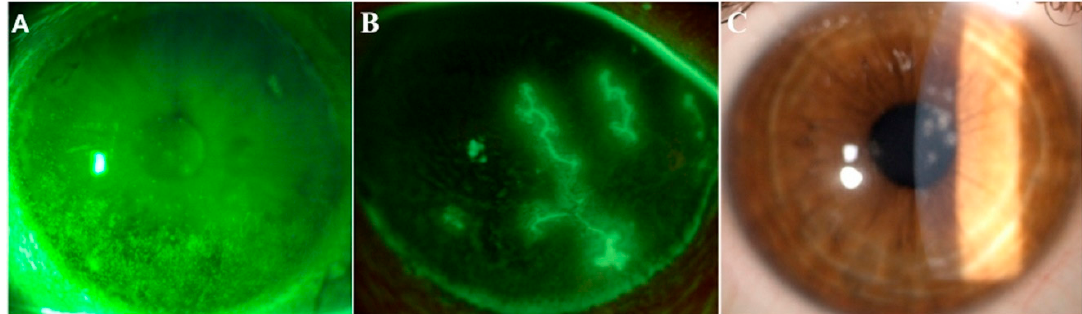
Figure 2. Images from three representative patients affected by dry eye, herpetic keratitis and adenoviral keratoconjunctivitis. Representative images of ocular conditions that may benefit from the use of lactoferrin: dry eye (Part A ), herpetic keratitis (Part B ) and epidemic keratoconjunctivitis (Part C ). (a) Slit lamp photograph of the cornea of a patient with dry eye after the instillation of 20 μ L of unpreserved 2% sodium fluorescein and use of the yellow filter to enhance the staining details. The epithelial damage is visible with fluorescein staining as multiple punctate epithelial erosions scattered over the corneal surface, in particular in the lower sectors. (b) Slit lamp photograph of the cornea of a patient with herpetic keratitis after the instillation of 20 µ L of unpreserved 2% sodium fluorescein and use of the yellow filter to enhance the staining details. Classical dendritic epithelial defects are visible with positive fluorescein staining. (c) Slit lamp photograph of a patient with adenoviral conjunctivitis showing multifocal sub-epithelial (stromal) corneal infiltrates.